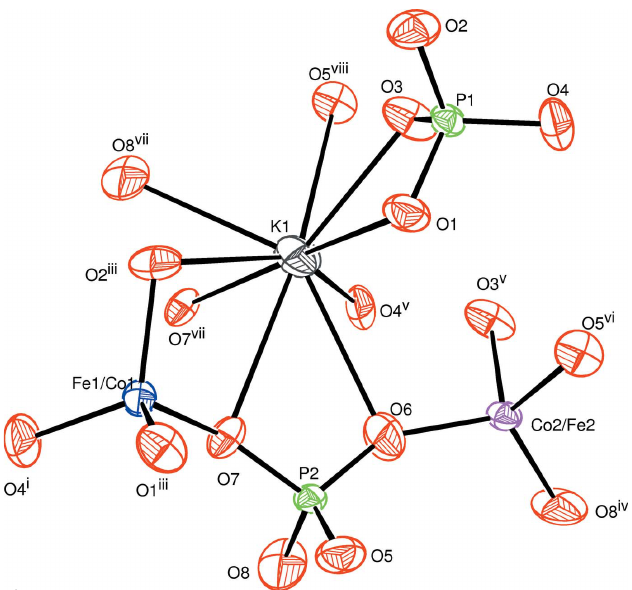
; (iii) (cid:2) x + 1, y , (cid:2) z + 1 ; 2 2 ; (v) (cid:2) x + 1 , (cid:2) y + 1 , (cid:2) z ; (vi) x , (cid:2) y , z (cid:2) 1 ; (vii) (cid:2) x + 1 , 2 2 2 2 2